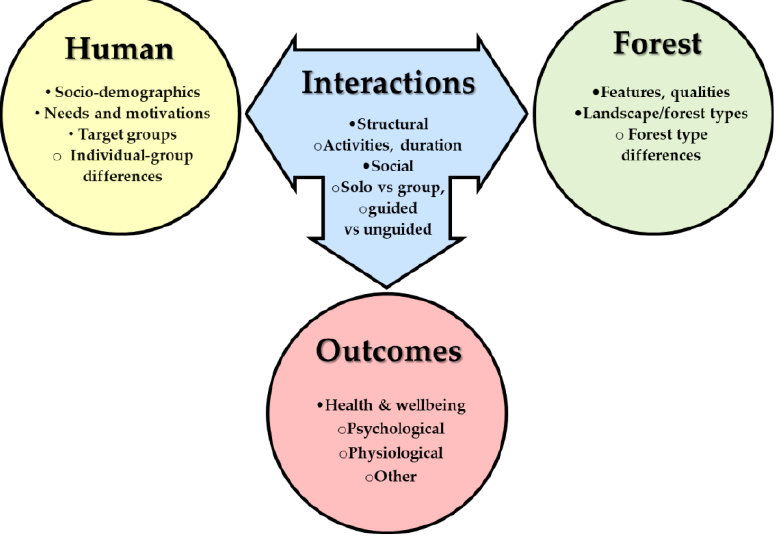
Figure 1. Forest therapy interaction process.